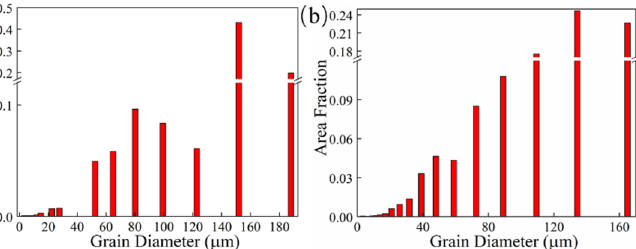
Figure 9. The distribution of grain sizes in the in-air and underwater OZs: ( a ) the in-air OZ; ( b ) the underwater OZ.